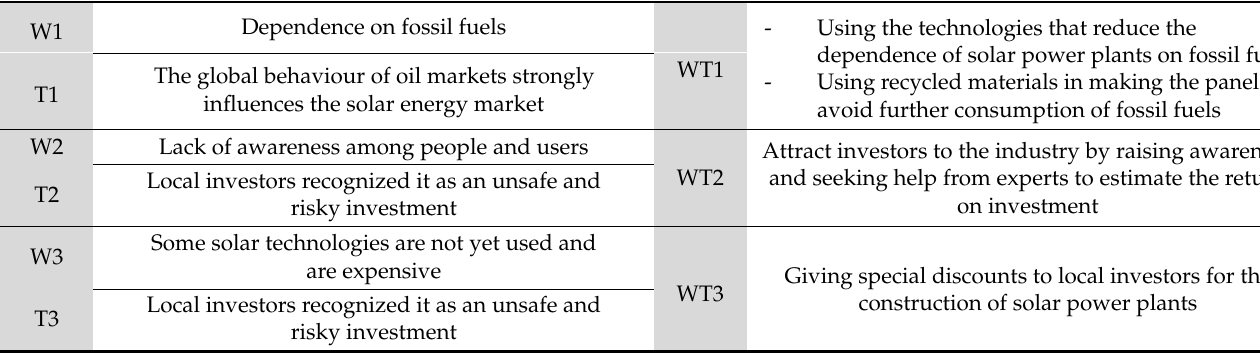
Table 4. WT array of the